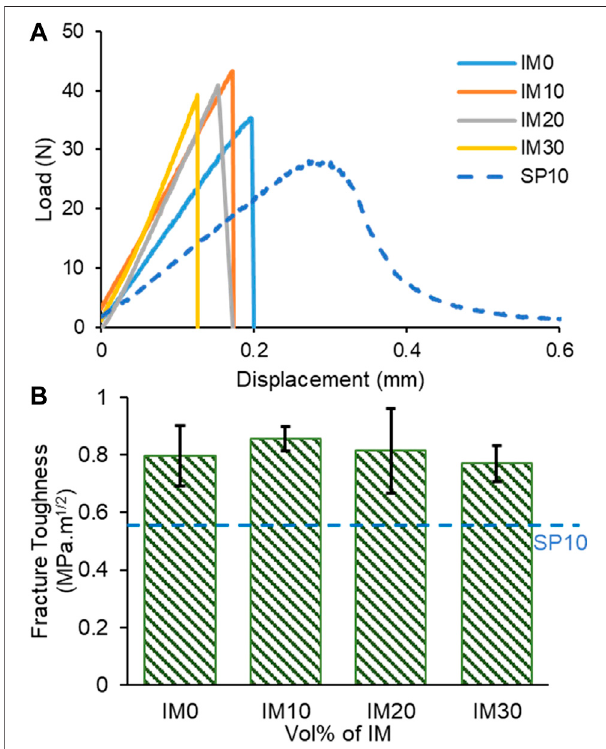
FIGURE6| Fracturebehaviorofthenanocomposites: (A) representative load versus load-line de fl ection curves from SENB tests, and (B) corresponding plane-strain fracture toughness (K 1C ) values. Data are presented as mean ± SD ( n = 7). One-way ANOVA and Tukey ’ s multiple comparison test were used for statistical analysis. Data are not statistically different. The dotted blue line represents the corresponding values for SP10, an AESO/PEGDA/nHA based nanocomposite from our previous work (Mondal et al., 2021).